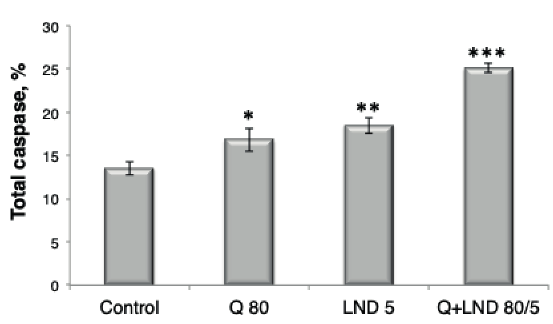
Figure 6. Q+LND combination downregulated MMP2/9 mRNA expression in a dose-dependent manner. ΔΔCt method was used to determine relative mRNA expression of MMP-2/9 gene in MCF-7 cells. Mean ± SD are shown (n = 3). The differences are *** from control, p <